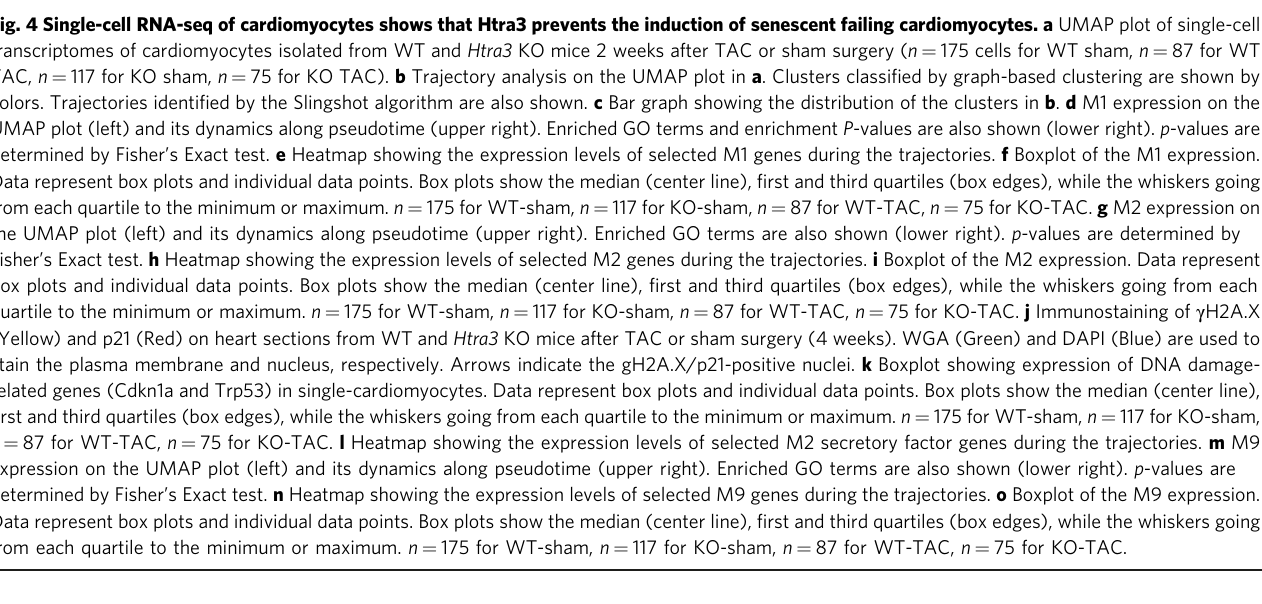
DNA damage and activation of p53 signaling, resulting in the induction of failing cardiomyocytes with expression of TGF- β signaling-related molecules and secretory factors, similar to senescence in proliferative cells 2,38,39 .